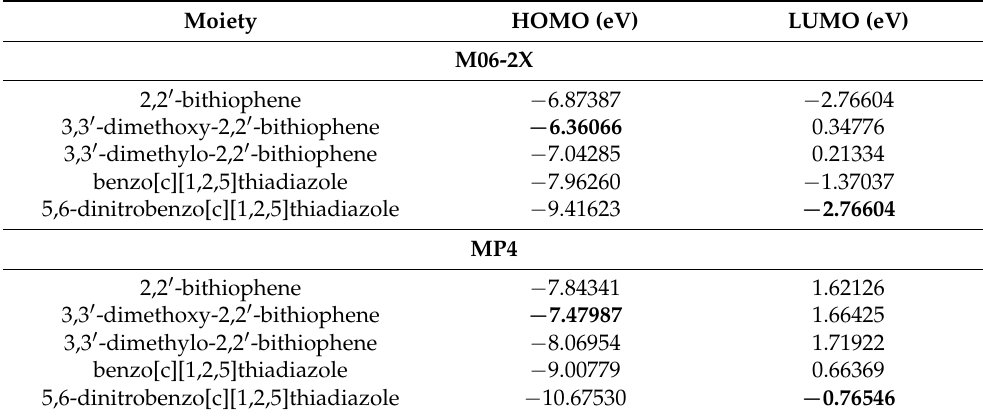
Table 1. Values of calculated HOMO and LUMO levels for various donor and acceptor